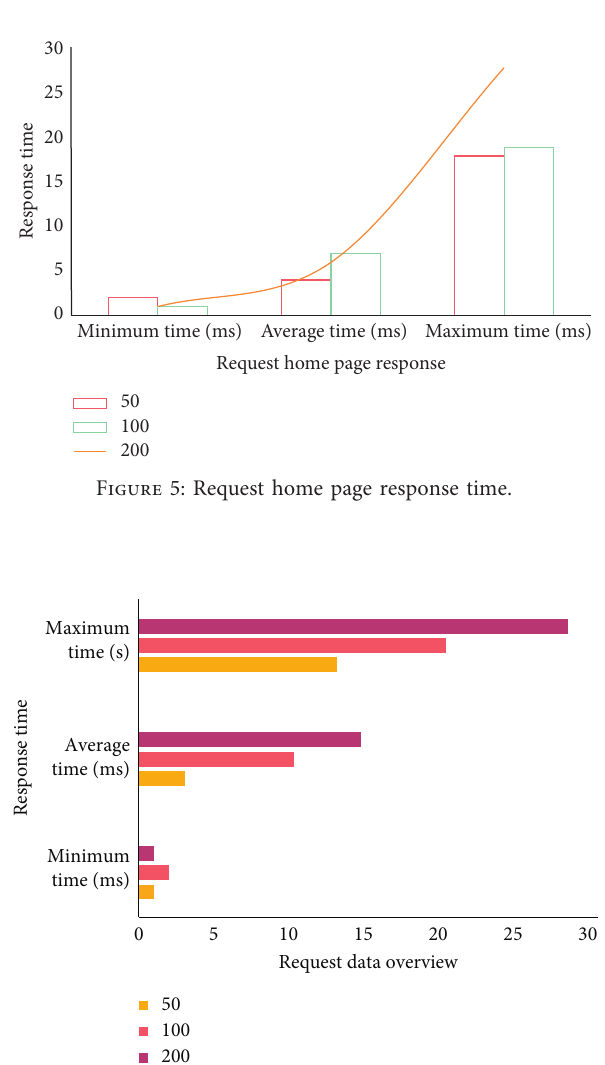
Figure 6: Request data overview response time.